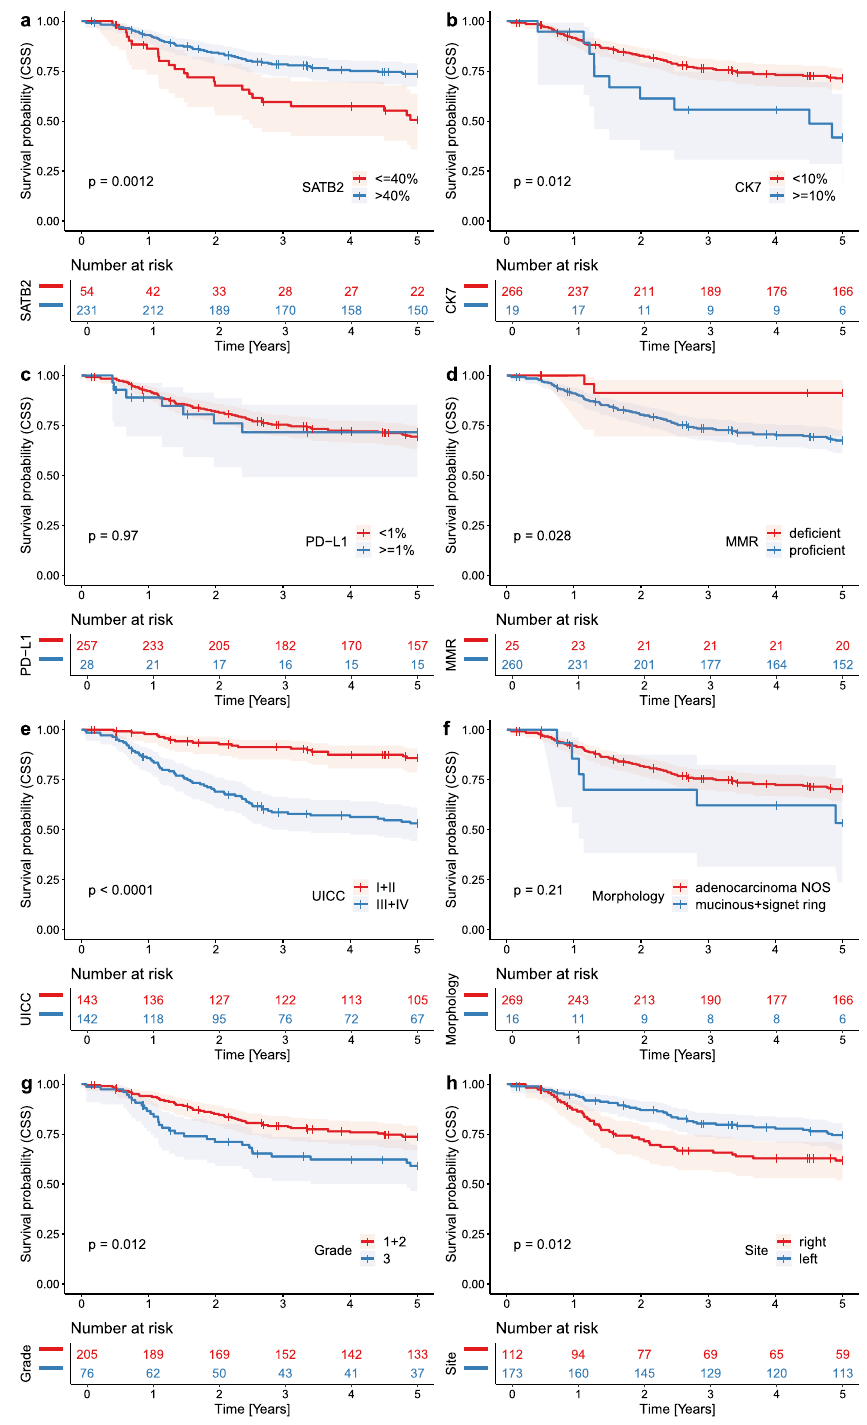
Figure 3. Entire cohort, Kaplan Meier curves documenting worse 5-year cancer-specific survival (CSS) in patients with CRC with SATB2 low expression ( a ), CK7 high expression ( b ), mismatch-repair proficient status ( d ), advanced stage ( e ), high-grade tumors ( g ), and right-sided tumor localization ( h ). There is little and no impact of a mucinous or signet ring morphology ( f ), and PD-L1 expression ( c ), respectively. P values from the log-rank test < 0.05 indicate a significant difference in